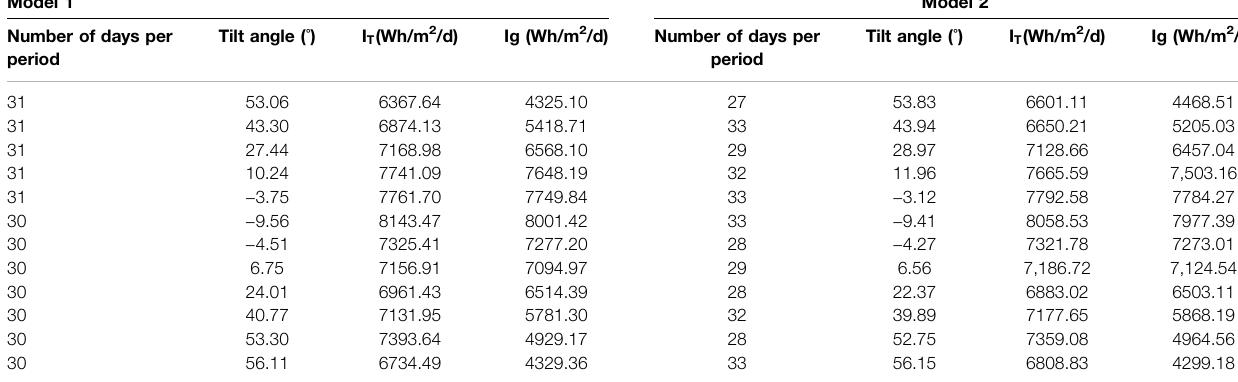
TABLE 2 | Optimal results found for Yanbu city for NP (cid:1)